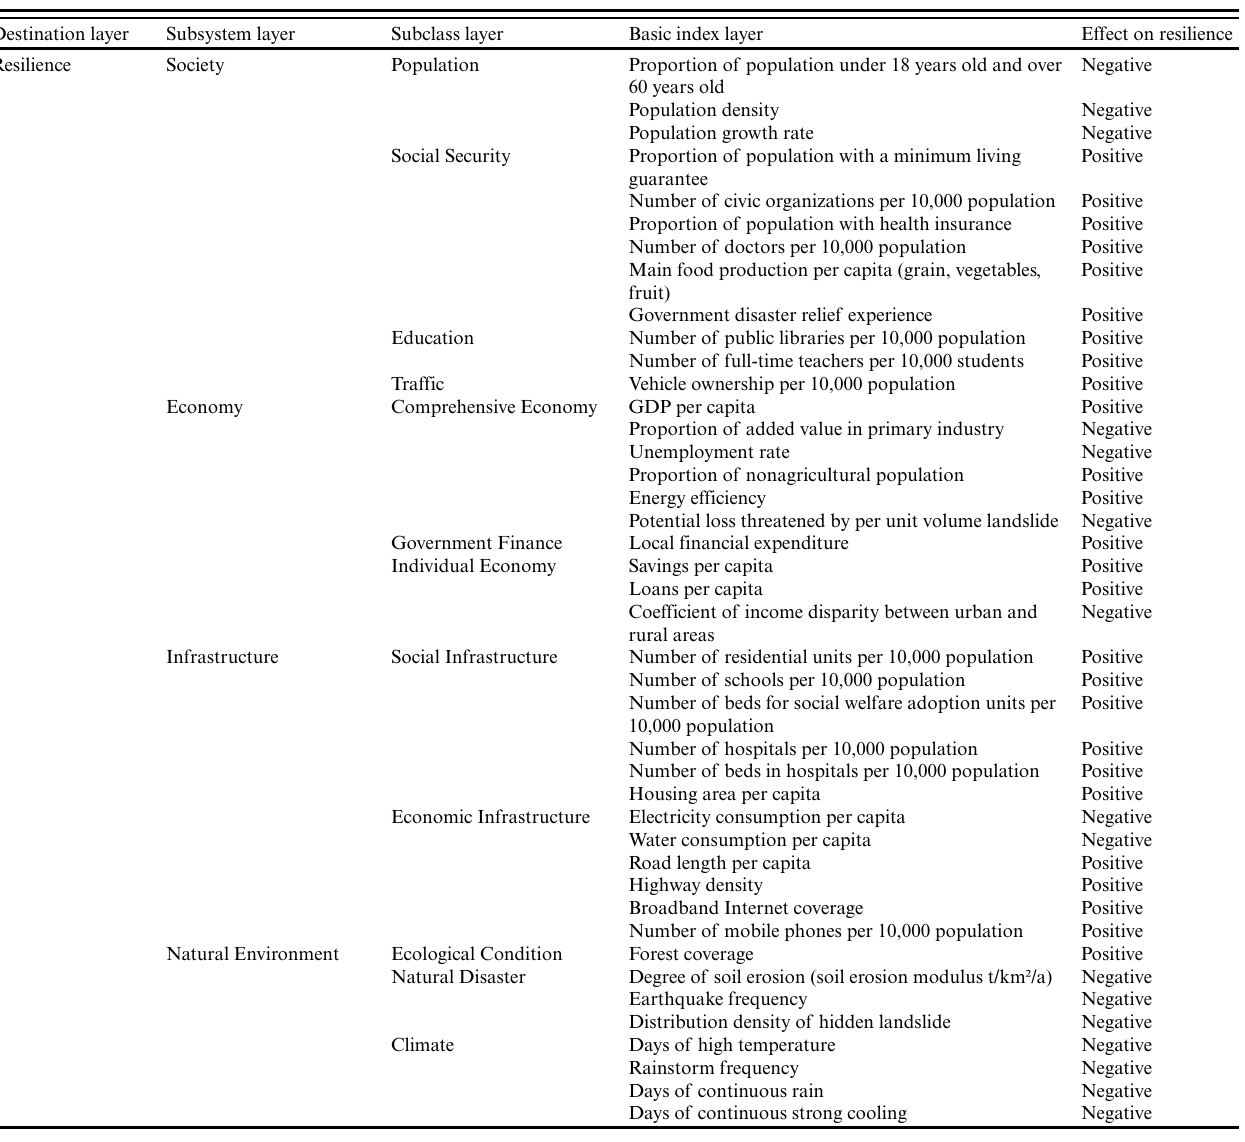
Table 3 . Disaster resilience evaluation